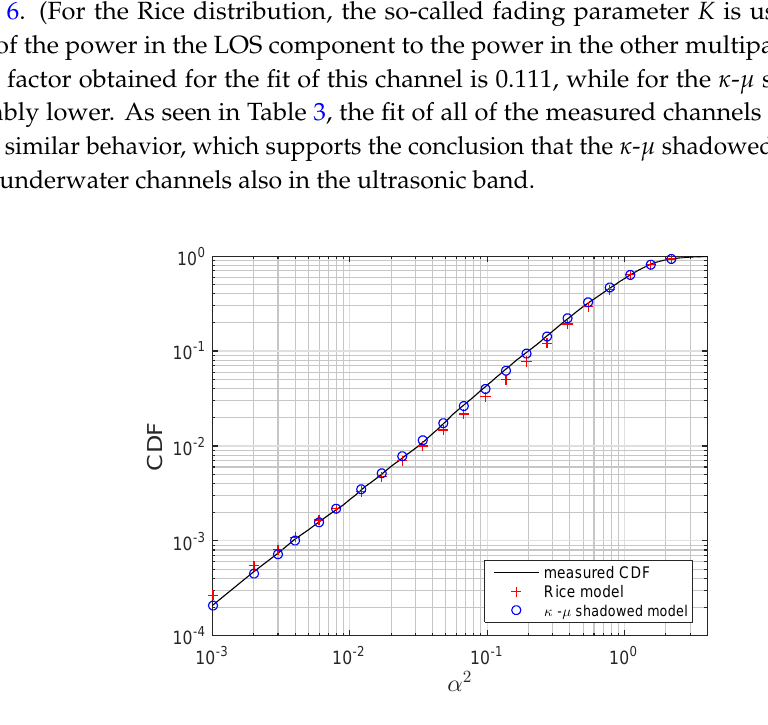
Figure 6. Example of the κ − µ model fit and the Rice model fit for one of the measured channels: